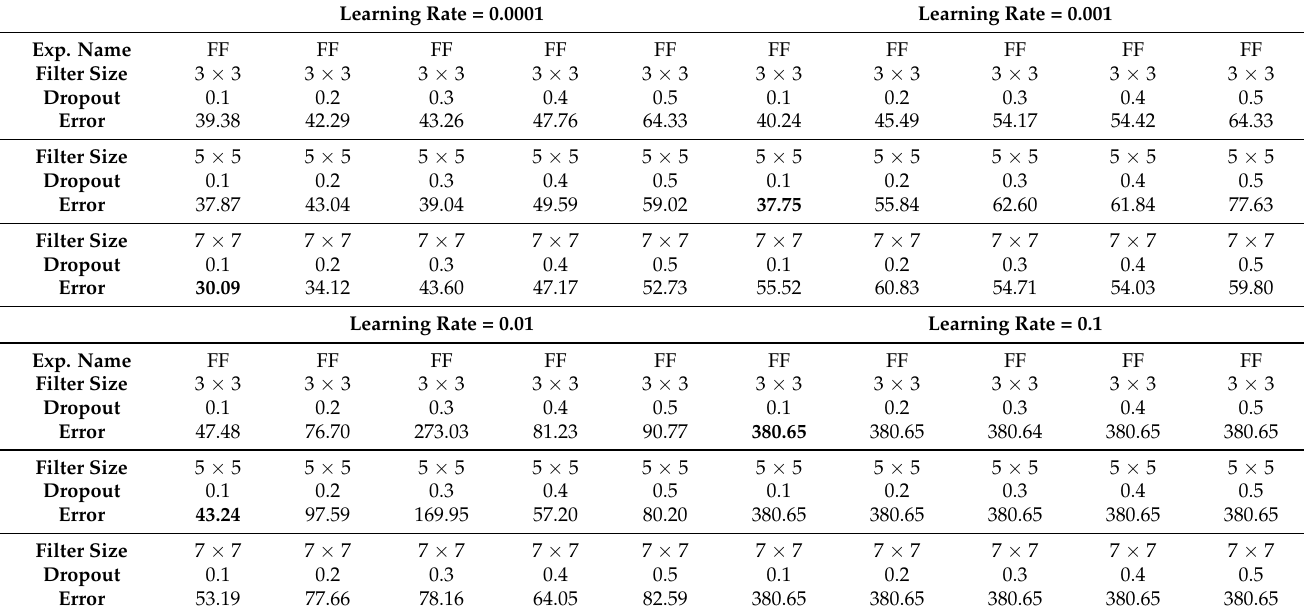
Table 7. Results of